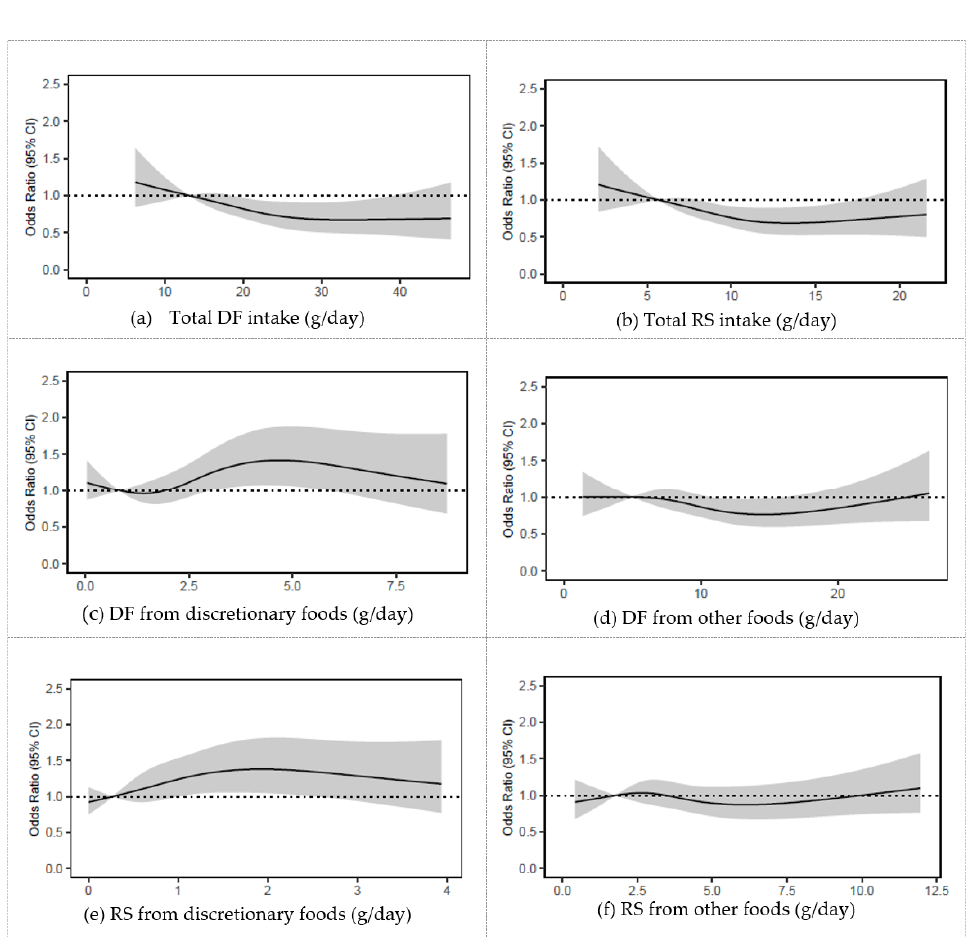
Figure A2. Odds ratios from logistic regression models with restricted cubic spline curves describing the association between baseline consumption of ( a ) total DF, ( b ) total RS, ( c ) DF from discretionary foods, ( d ) DF from other foods, ( e ) RS discretionary foods, ( f ) RS from other foods, in g/d with 5 year MCS scores (vertical axis) in 4067 Australian adults from the AusDiab study (excludes those with baseline MCS score < 47). Odds ratios are based on models adjusting for age, sex, BMI, energy intake, relationship status, physical activity, level of education, the socio-economic index for areas (SEIFA), smoking status, diabetes status, and self-reported history of CVD, and are comparing the specific level of intake (horizontal axis) to the median (IQR) intake for participants in the lowest intake quartile of total DF: 13 g/day; total RS: 6 g/day; DF from discretionary foods: 0.8 g/day); DF from other foods: 5 g/day; RS from discretionary foods 0.3 g/day; RS from other foods: